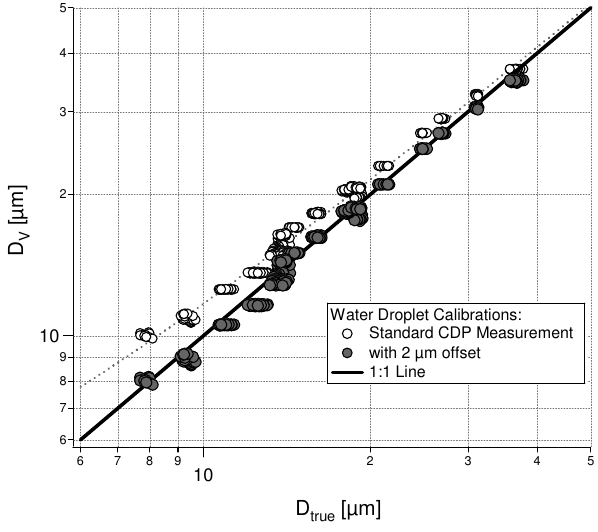
Fig. 5. Volume mean diameter ( D V ) from the standard CDP measurement versus D true determined from images of the droplet